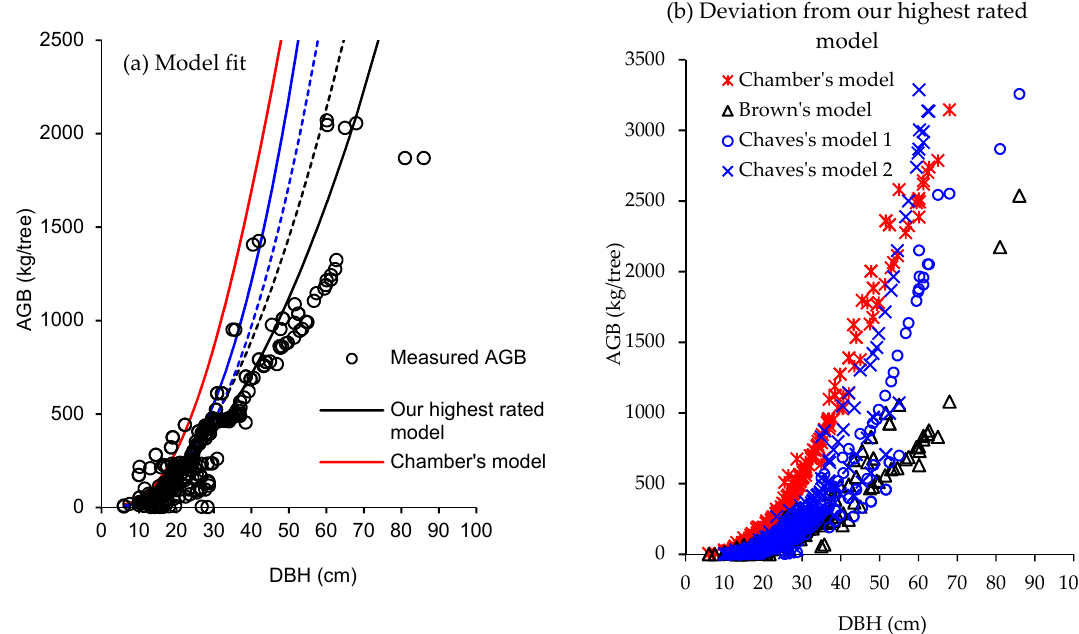
Figure 4. Comparison of models using ( a ) fitted values and ( b ) departures from our highest rated model across values of tree diameter at breast height (DBH).